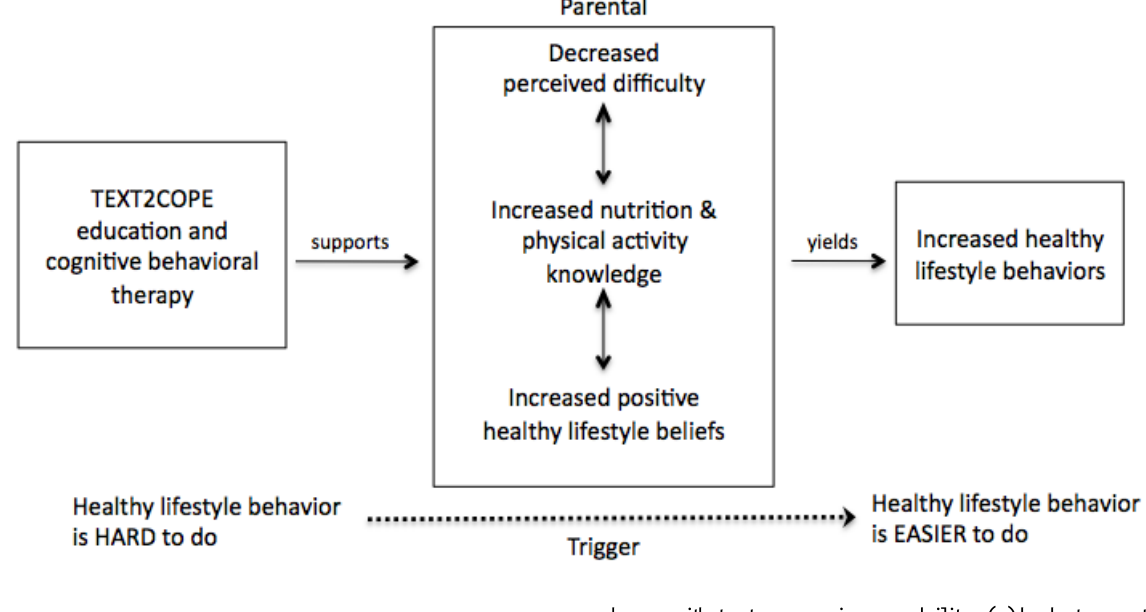
Figure 1. Conceptual model of the TEXT2COPE